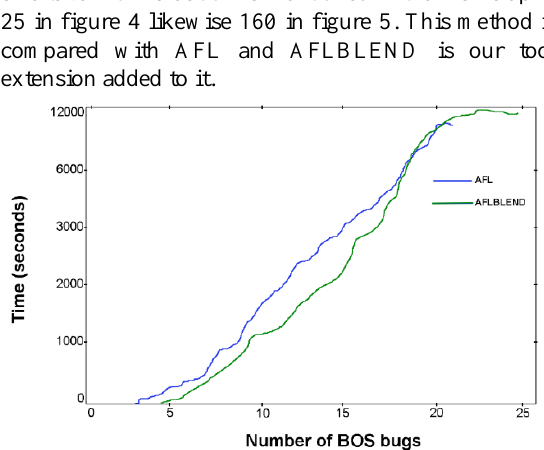
Fig. 4 : Results for buffer overflow susceptibilities